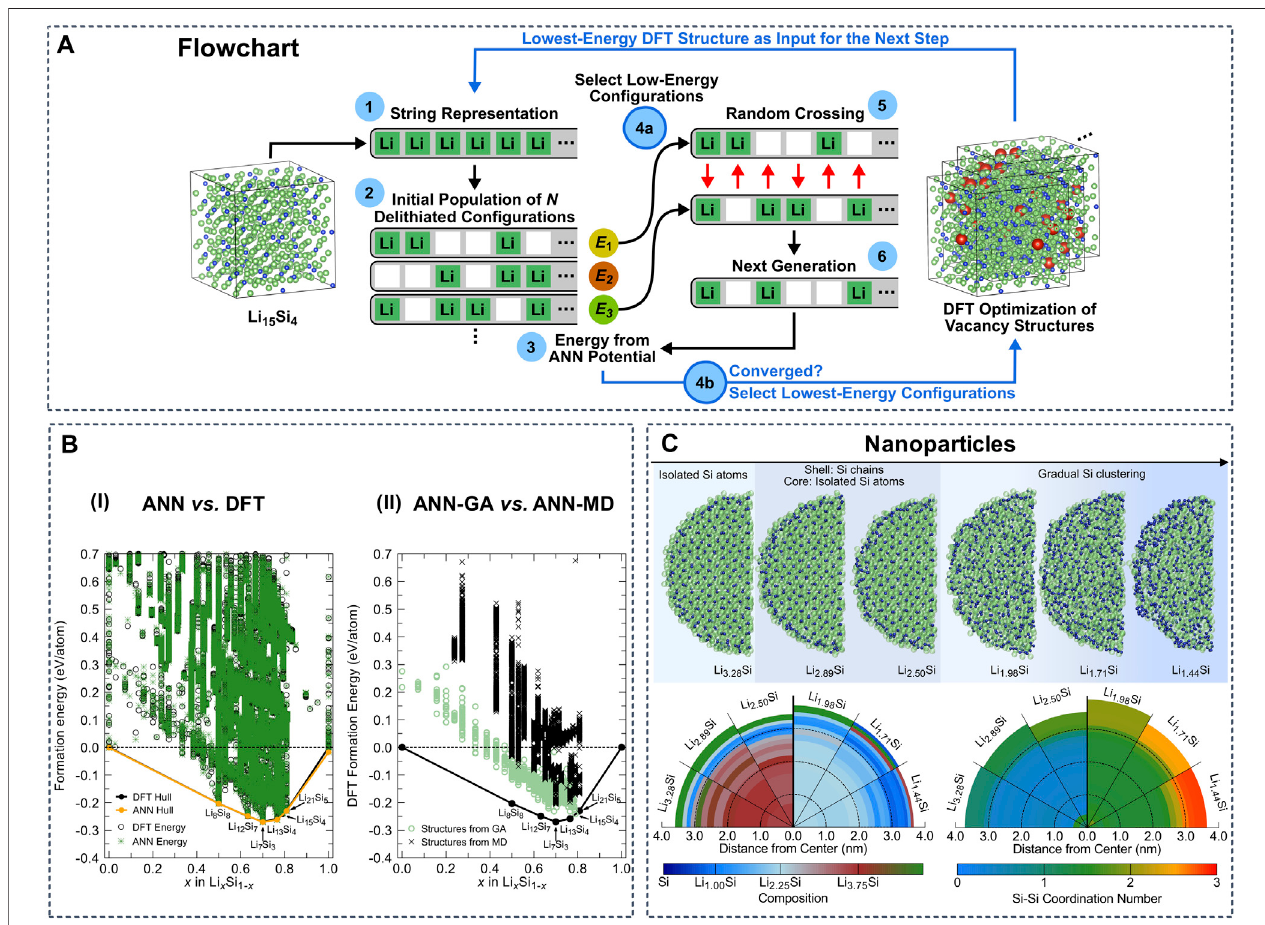
FIGURE 5 | (A) Schematic of genetic algorithm (GA) sampling using a specialized ANN potential. Reproduced with permission from (Artrith et al., 2018). Copyright 2018 American InstituteofPhysics (B-I) Phasediagram based on theformation energies of ∼ 45,000Li x Sistructuresincluding bulk, surface slab, and cluster structures. The energies predicted by the general ANN potential are shown as green stars and the DFT reference energies are black circles. (B-II) DFT formation energies of those structures sampled by the GA with the specialized ANN potential (green circles) and those generated during MD melt-quench simulations with the general ANN potential (black crosses). Reproduced with permission from (Artrith et al., 2018). Copyright 2018 American Institute of Physics (C) Si atoms segregate into clusters and chains during the delithiation of LiSi nanoparticles with 12,000 atoms. Reproduced with permission from (Artrith et al., 2019). Copyright 2019 arXiv.